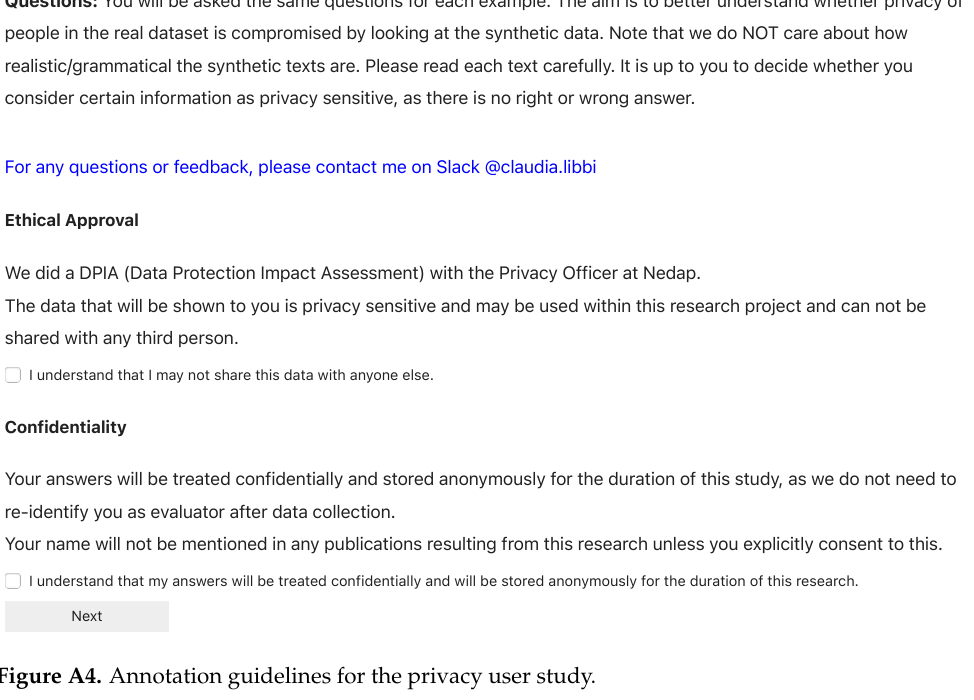
Figure A4. Annotation guidelines for the privacy user